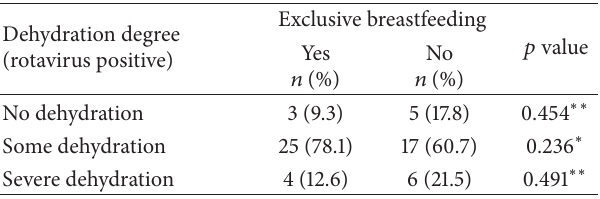
Table 3: Association between severe dehydration and exclusive breastfeeding in infants with rotavirus